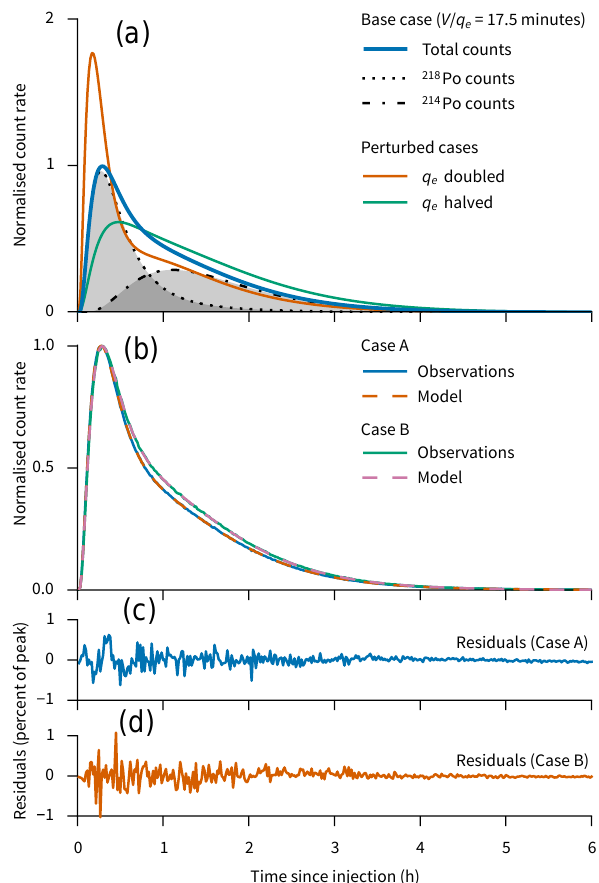
Figure 3. Modelled and observed detector response to a radon source injected for 1min at time zero. Panel (a) shows the sim- ulated response of the 700L radon detector during normal opera- tion (base case) including a break down between contributions from polonium–218 and polonium–214 counts. Also shown is the effect of changing the external flow rate, q e . Panel (b) shows the observed and modelled detector response, comparing 2days which have dif- fering detector responses, interpreted as a change in the fraction of polonium–218 progeny lost from the screen after alpha decay. Pan- els (c) and (d) show the residuals (observed minus modelled counts) after fitting the modelled response to observations. The pulse con- centration is not precisely known, and not necessarily the same each day, so the detector response is normalised (by total counts in a and by peak counts in b ). The normalisation factor, in b , is approxi- (cid:16) (cid:17) mately 1 / 1500counts − 1 . Over eight injections, the number of counts 0–5h after injection has a coefficient of variation of